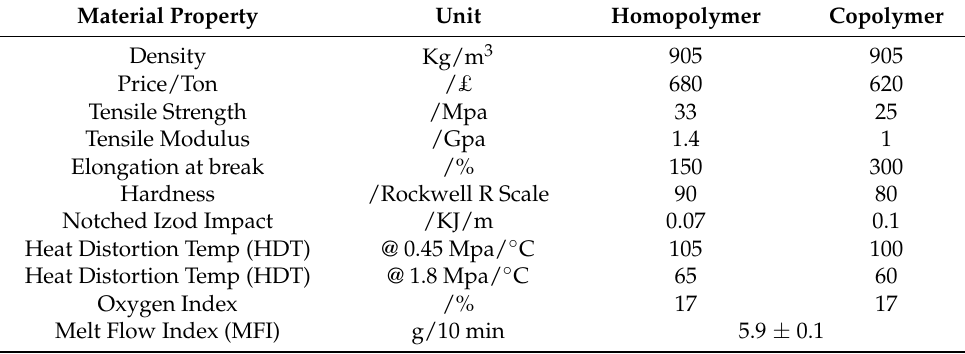
Table 3. Material properties of polypropylene (i.e., a copolymer) [19].